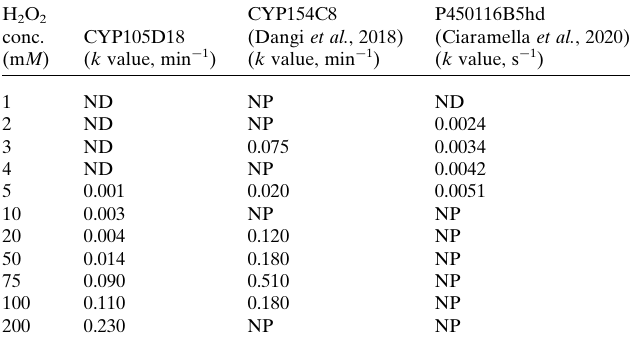
Table 1 Rates of heme oxidation ( k ) for CYP105D18 in the presence of different H 2 O 2 concentrations and comparisons with available literature. ND: not detected. NP: not performed.